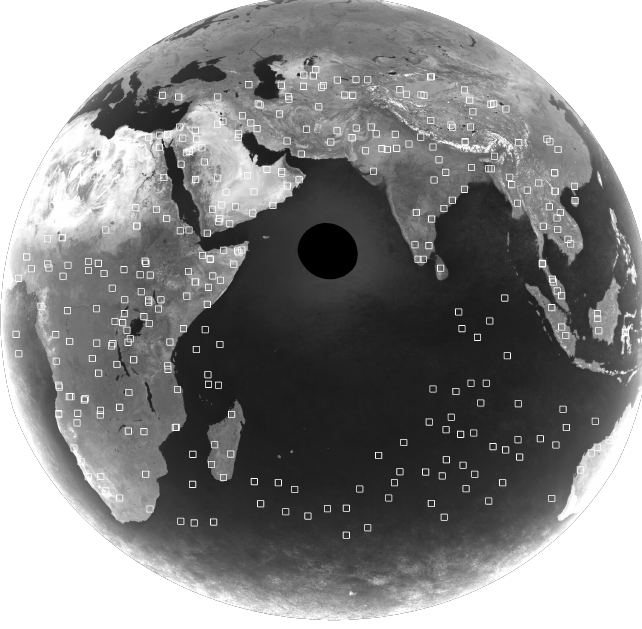
Figure 13. The selected clear-sky stable sites on top of the Meteosat FOV above the Indian Ocean for the IODC of Meteosat-5 at 63 ◦